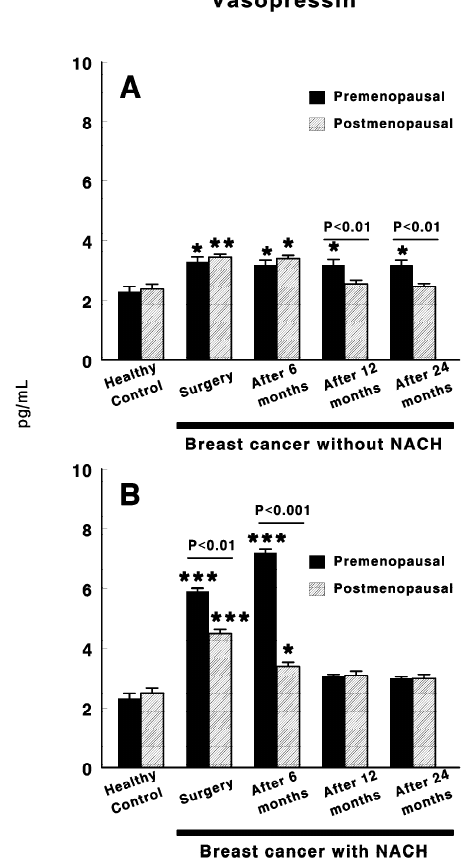
Figure 3. Circulating vasopressin levels in control, preMP and postMP women and in women diagnosed with ductal infiltrating BC that were untreated ( A ) or treated ( B ) with NACH, at the moment of the surgery and 6, 12 and 24 months after surgery. Asterisks represent significant di ff erences between breast cancer patients and healthy control women. The upper lines between bars represent the significant di ff erences between premenopausal and postmenopausal women. Results are expressed in pg / mL (Mean ± SEM; * p < 0.05; ** p < 0.01; *** p < 0.001).